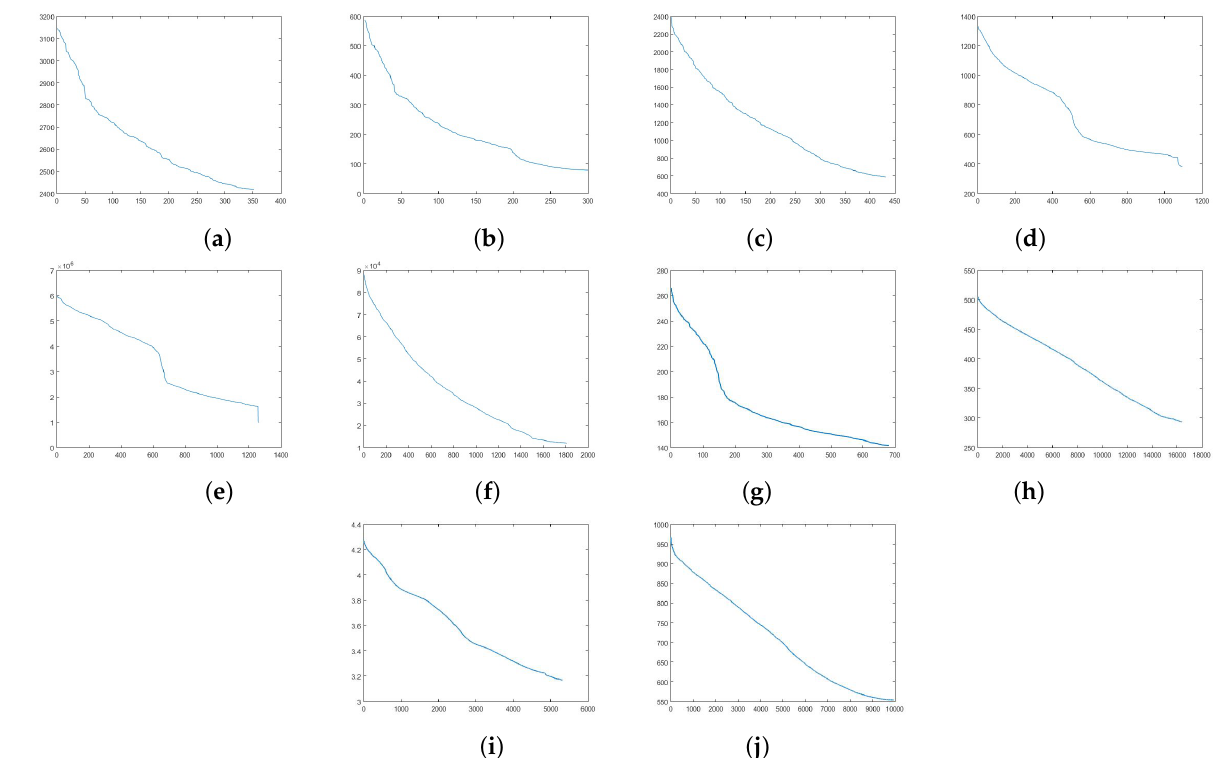
Figure 6. Descent stability of FAGP on 6 UCI datasets: Ionosphere ( a ), Iris ( b ), Seeds ( c ), Glass ( d ), Segmentation ( e ), Dermatology ( f ), Breast ( g ), Natural ( h ), Yeast ( i ), and Waveform ( j ). The x-axis shows the iteration number. The y-axis shows the objective function